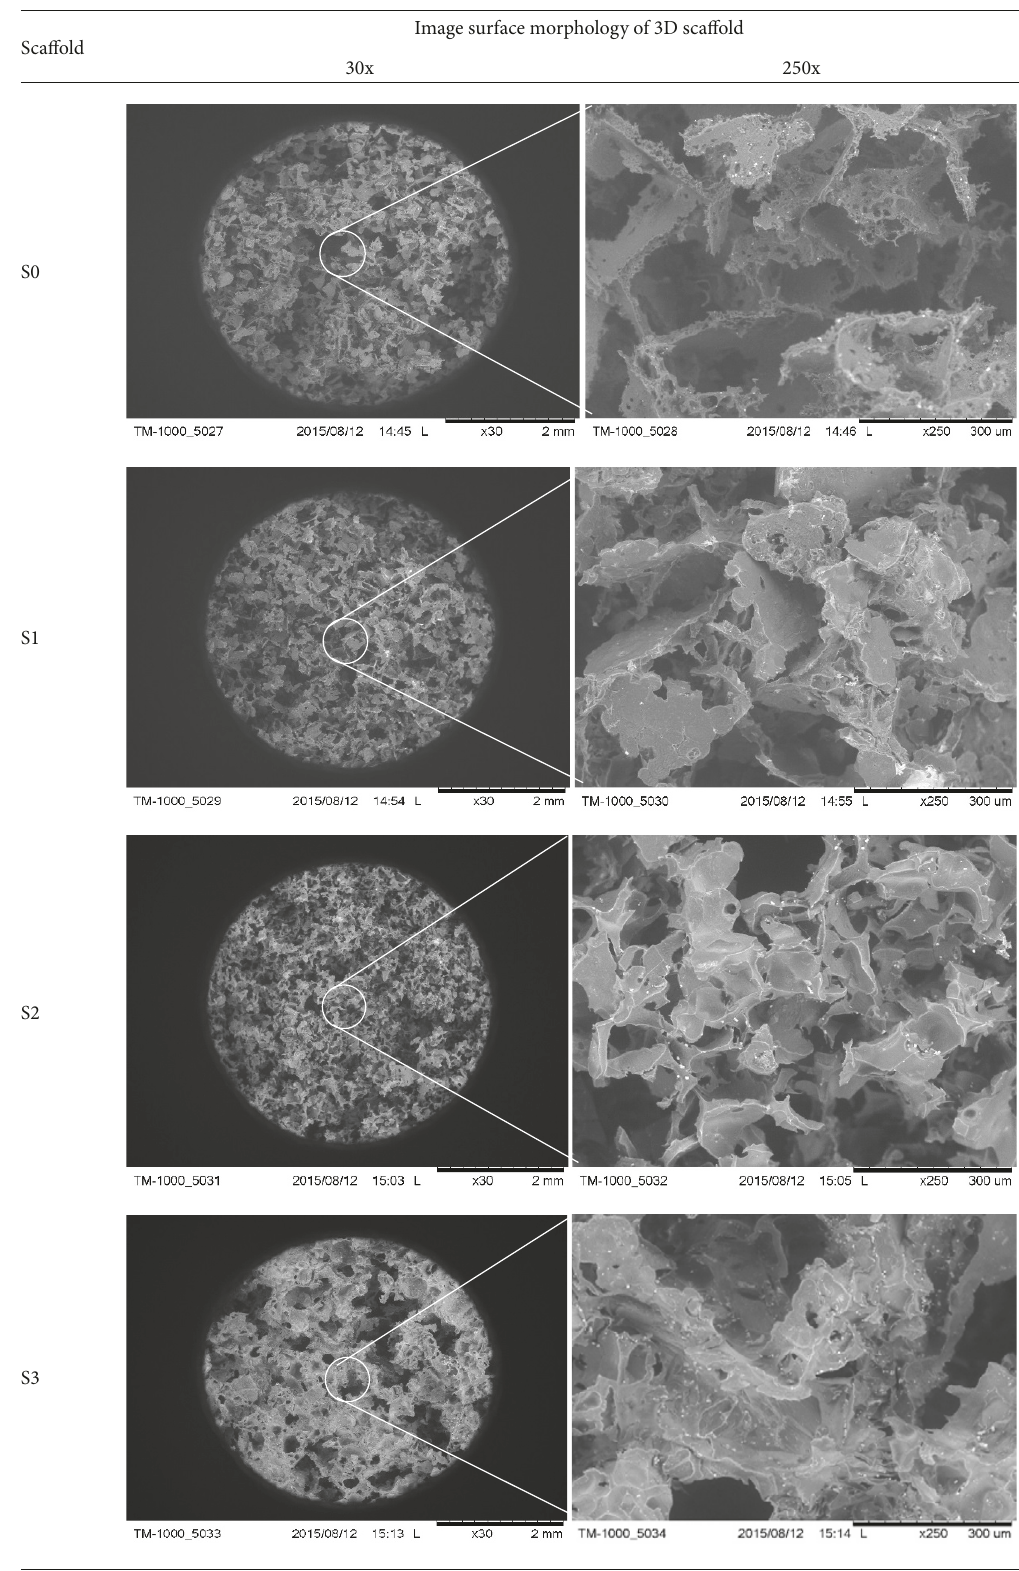
Figure 10: Scanning electron micrograph images of the infused carrageenan 3D scaffolds (S0, S1, S2, and S3) 7 days after incubation. Images were enlarged from 30x (white circle) to